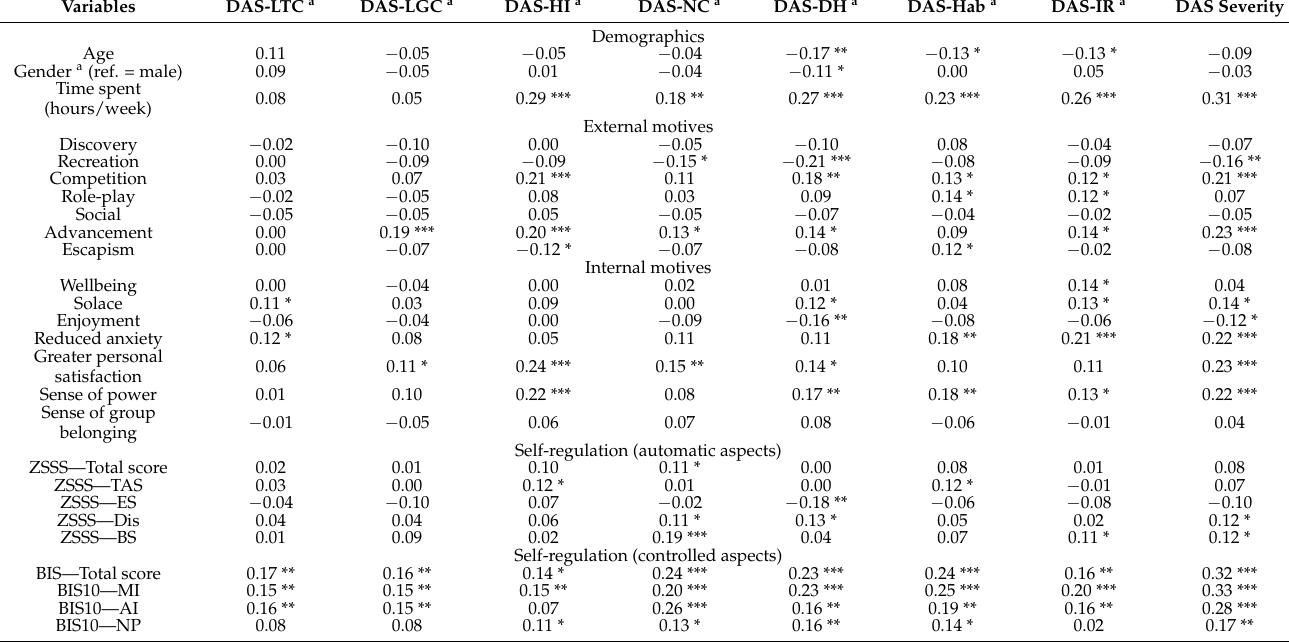
Table 1. Correlations between the symptoms of engagement in gaming according to DAS and demographics and psychological variables (N =